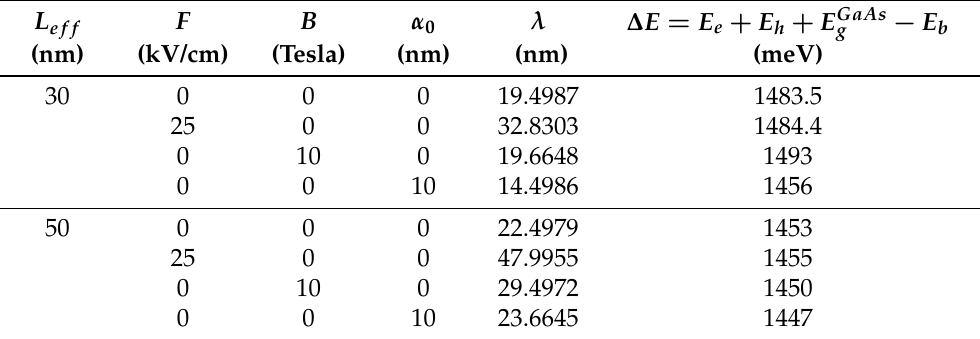
Table 3. The variations of λ and ∆ E parameters versus well sizes and external fields for V 3 ( z e ( h ) ) potential. L ef